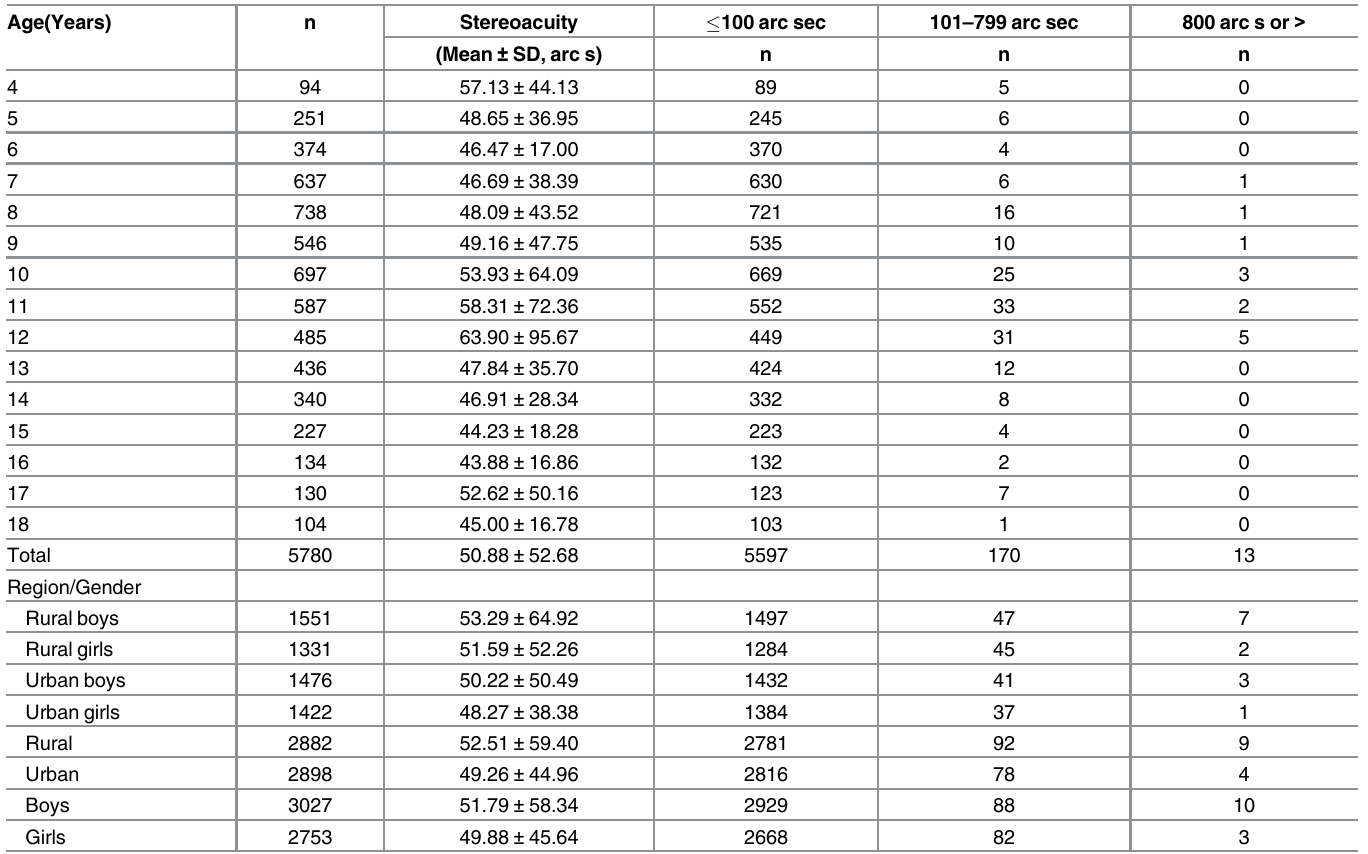
Table 2. Distribution Stereoacuity in the Shandong Children Eye Study Stratified by Age, Gender, and Region of Habitation.